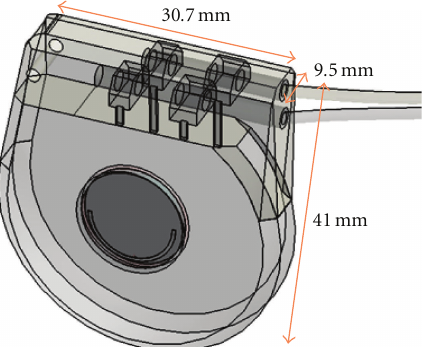
Figure 1: Typical dimensions of cardiac pacemaker battery pack [2].